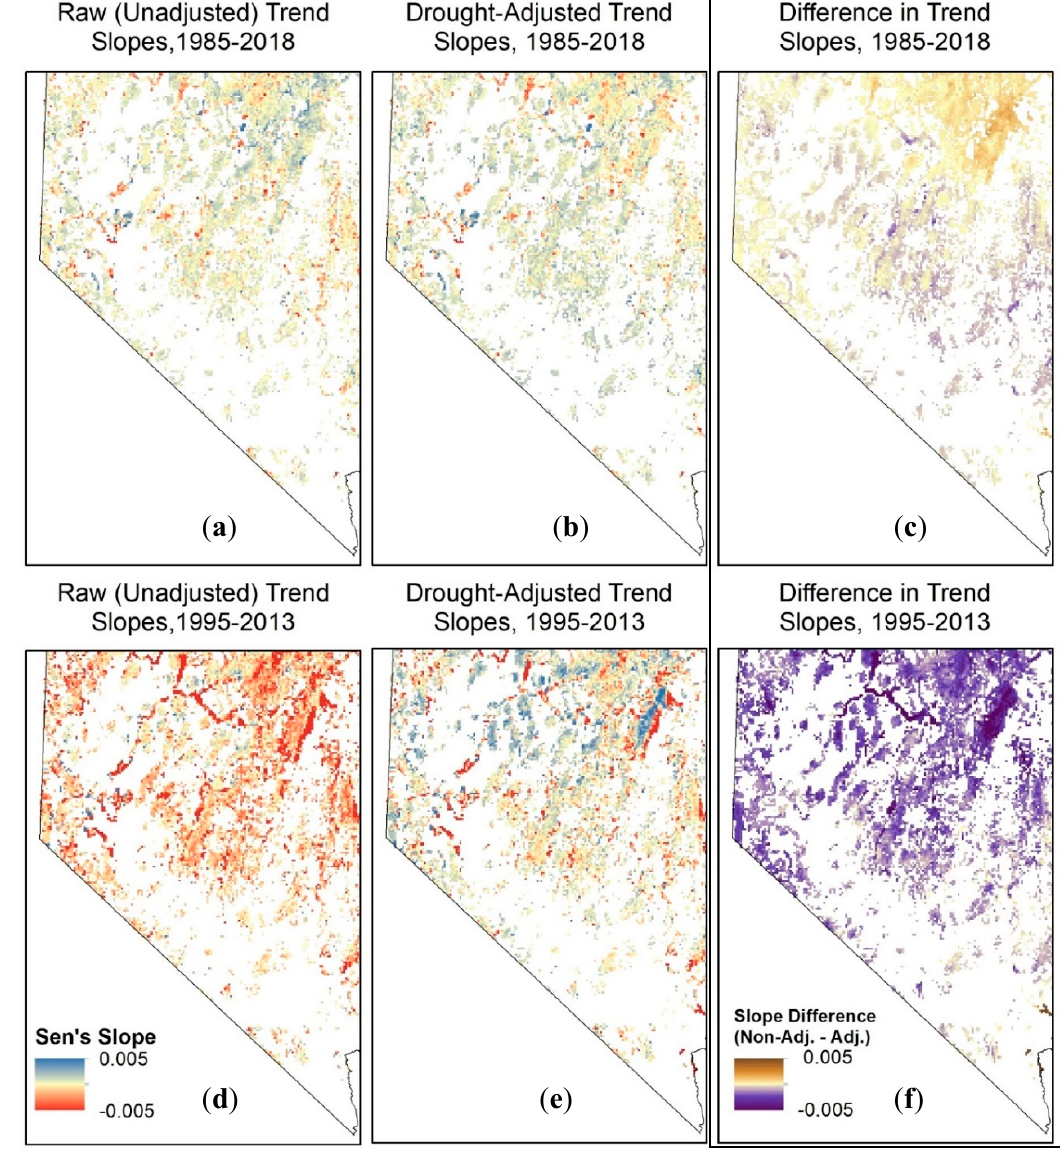
Figure 8. Raw (unadjusted; a , d ), drought-adjusted ( b , e ), and differences in NDVI trend slope values ( c , f ) for the full 1985–2018 study period ( a , b , c ) and a subset of years in the study period during which there is a downward (drying) trend in SPEI (1995–2013; d , e , f ). Results are represented here as averages across 100 × 100 30-m riparian cells (Figure 1) for visualization purposes. Trends for the 18-year (1995–2013) subset are presented here to demonstrate the value of the drought adjustment concept, with the acknowledgment that this time period is insufficient to reliably quantify trends. The optimal aggregation timescale for SPEI also varied considerably across the study region.